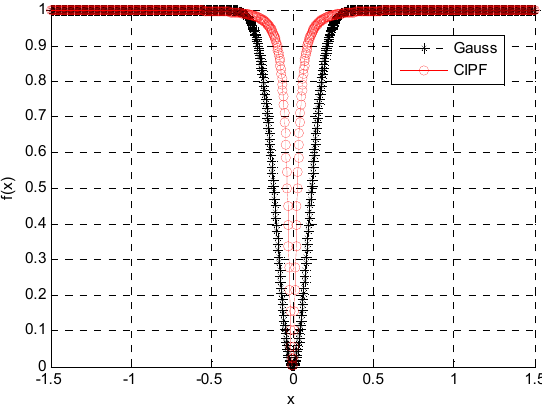
Figure 1. Comparison of CIPF and Gauss functions.